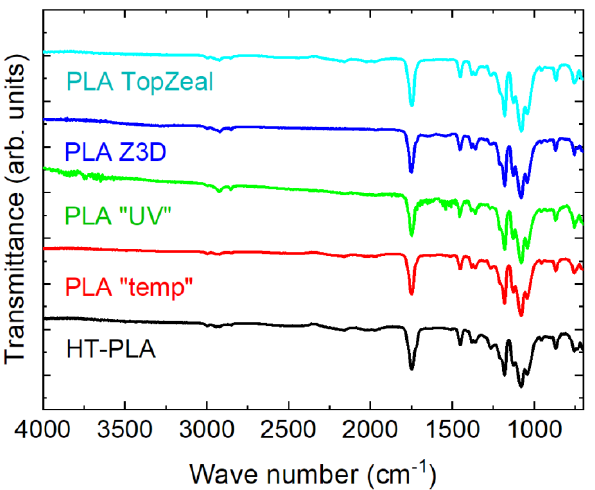
Figure 4. Fourier transform infrared spectroscopy (FTIR) measurements of the different PLA filaments used in this study. The graphs are vertically shifted for clarity. AFM images of the HT–PLA samples are depicted in Figure 5. In addition, the deep crack on the left side of the display window, no strong differences in the amplitude or phase images are visible. The phase image does not show any details that are not visible